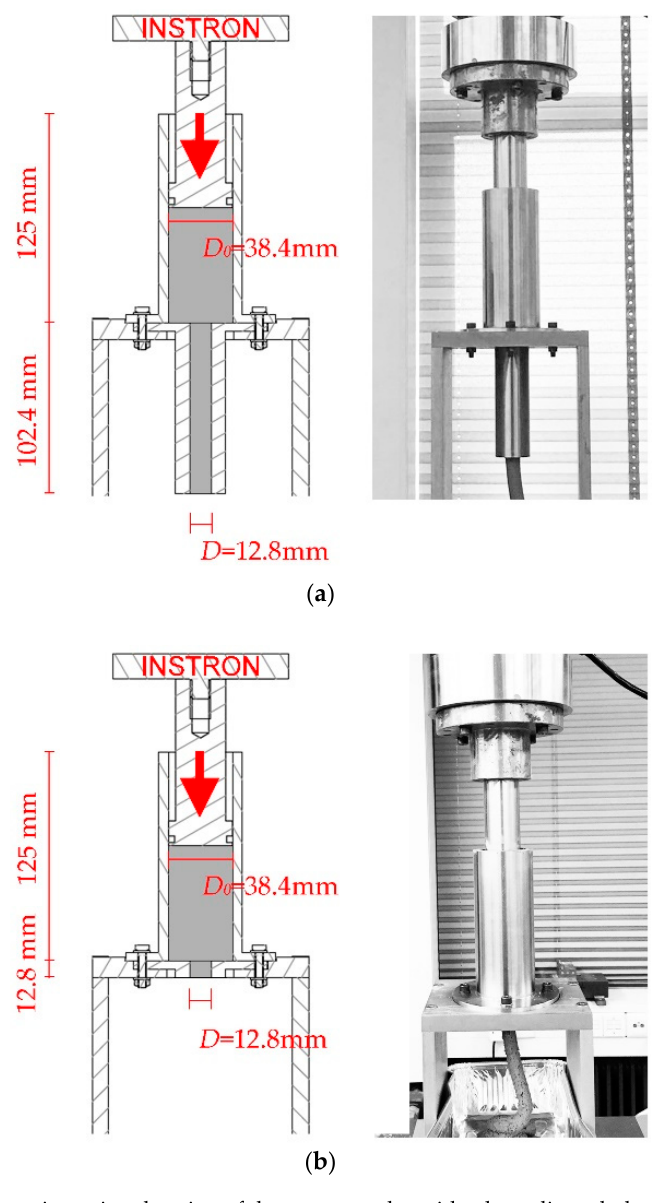
Figure 3. ( a ) Schematic section drawing of the ram extruder with a long die and photograph of the ram extruder with a long die; and ( b ) schematic section drawing of the ram extruder with a short die and photograph of the ram extruder with a short die.